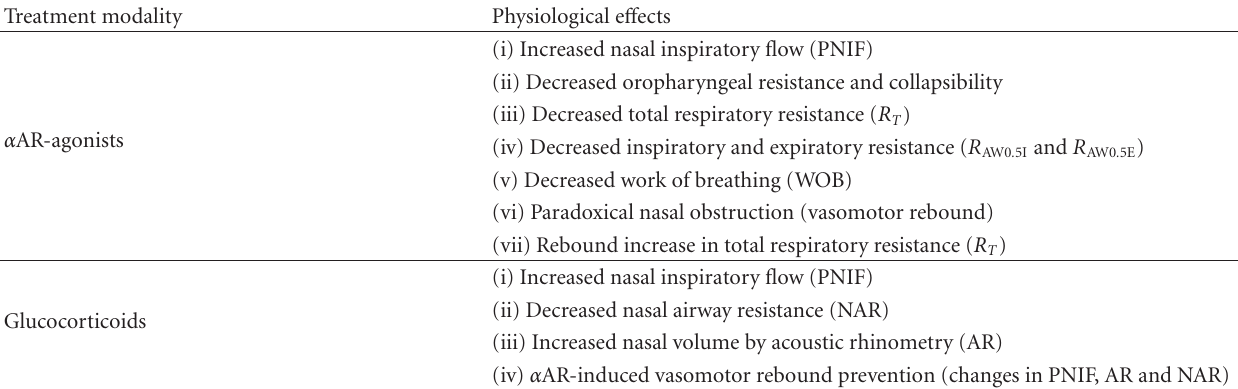
Table 2: E ff ects of α AR-agonists and glucocorticoids in upper airway breathing